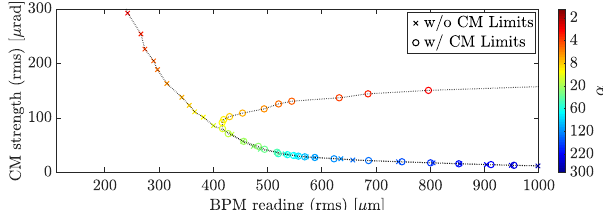
FIG. 17. RMS corrector strength as a function of the rms BPM reading after improving the initial transmission (cf. Sec. IV B) when using different regularization parameters α for the various feedback algorithms. Plotted are the mean values for both planes without corrector limits (cross) and including maximum corrector strength of 200 μ rad